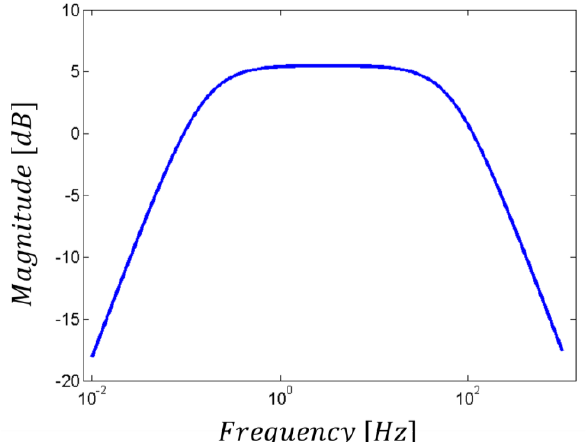
Figure 5. Active band-pass filter transfer function.